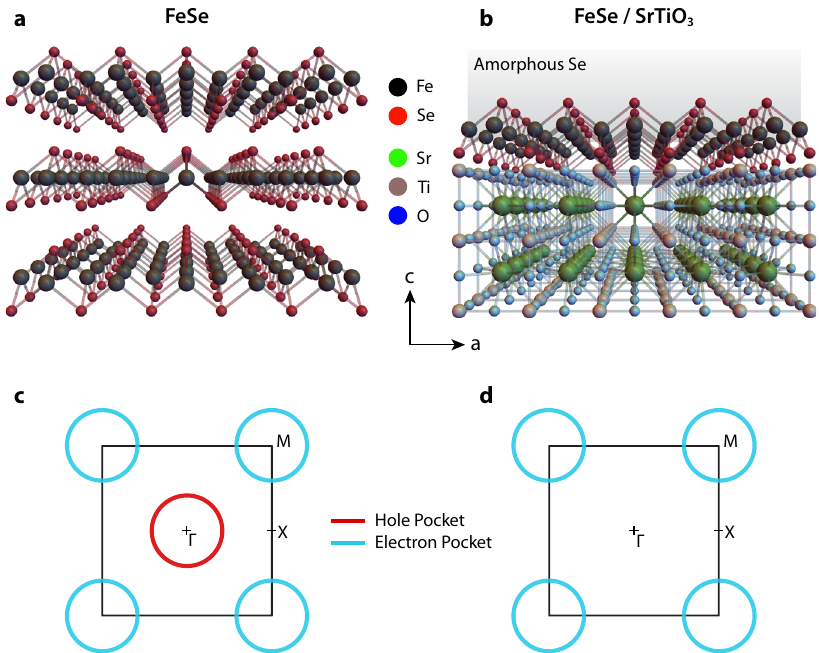
Fig. 1 Structure and Fermi surface of FeSe bulk and FeSe/SrTiO 3 (STO). a Structure of FeSe bulk. b Structure of FeSe/STO monolayer with Se capping. c , d Schematic Fermi surface of FeSe bulk ( c ) and FeSe/STO monolayer ( d ). The electron pocket of bulk FeSe has been drawn circular and not elliptical for simplicity and for correspondence with the theoretical model adopted